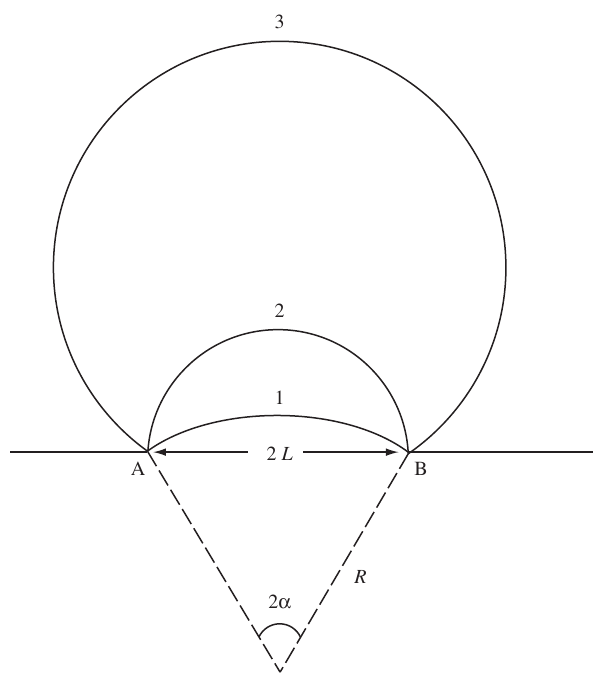
Figure 2. Model for the grain boundary migration induced by deformation, showing the successive migration stages 1, 2 and 3 57 .